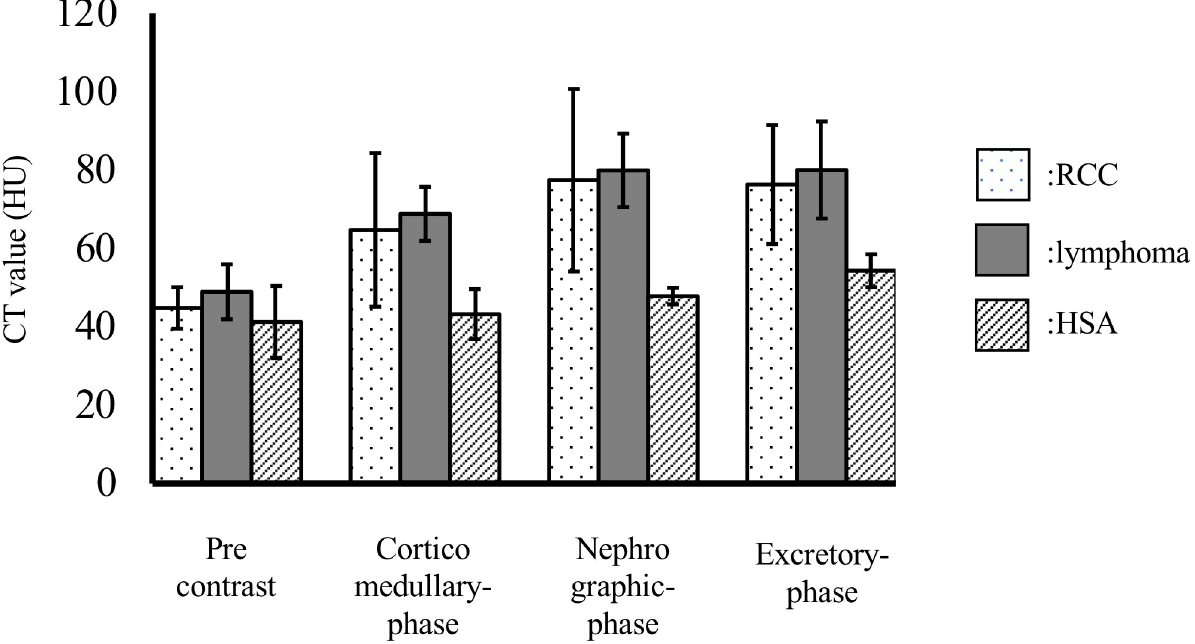
Fig 5. CT attenuation values of RCC, lymphoma, and HSA on pre-contrast images and post-contrast corticomedullary, nephrographic, and excretory phase images. Abbreviations: CT, computed tomography; HSA, hemangiosarcoma; RCC, renal cell carcinoma.